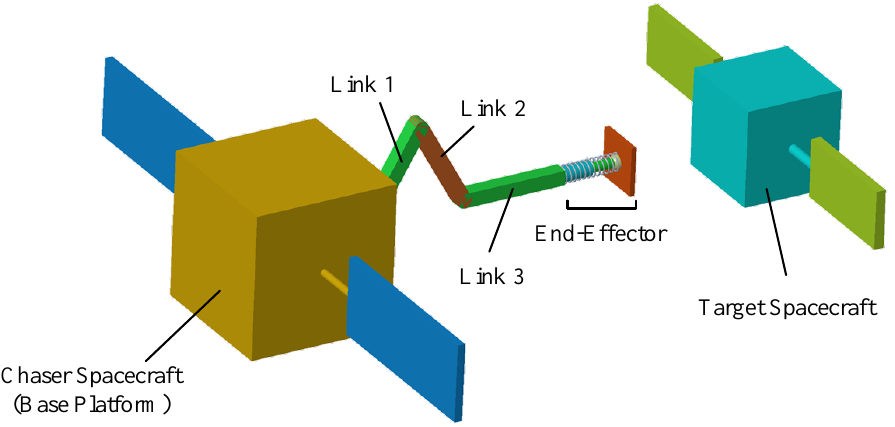
Figure 1. Multibody dynamic system of the chaser and target spacecraft.